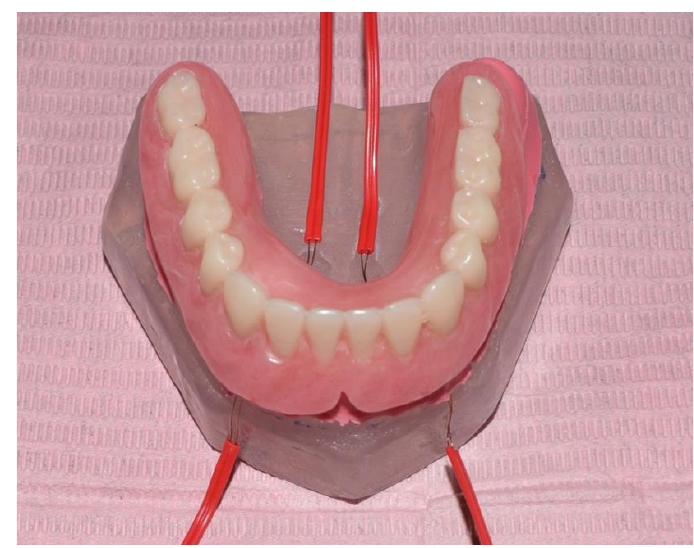
Figure 1b Over-denture placed on the pseudo realistic model with strain